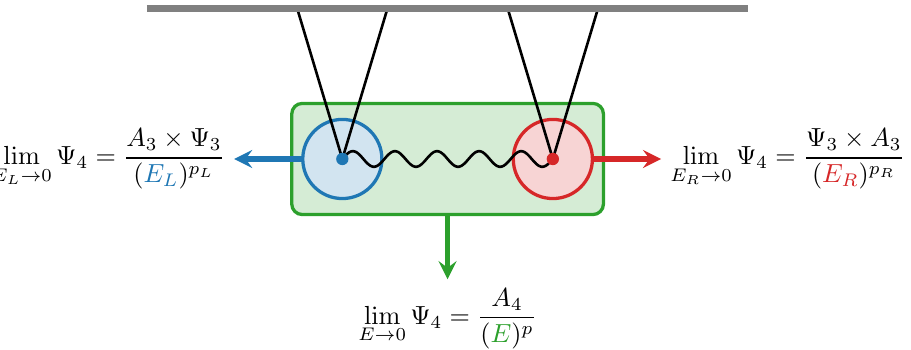
Figure 2: Illustration of the different singularities of four-point correlators in the s - channel. All correlators have a total energy singularity, while correlators arising from the exchange of a particle also have partial energy singularities when the energy at an interaction vertex is conserved. Requiring these singularities to have the correct residues is a powerful constraint on the structure of the correlators and in many cases fixes them